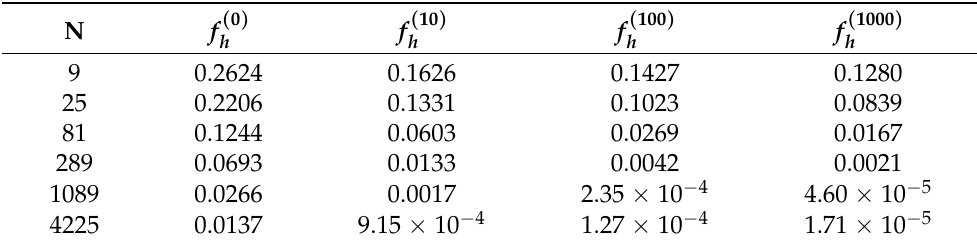
( 0 ) with p = 1. Data sites Ξ H . h